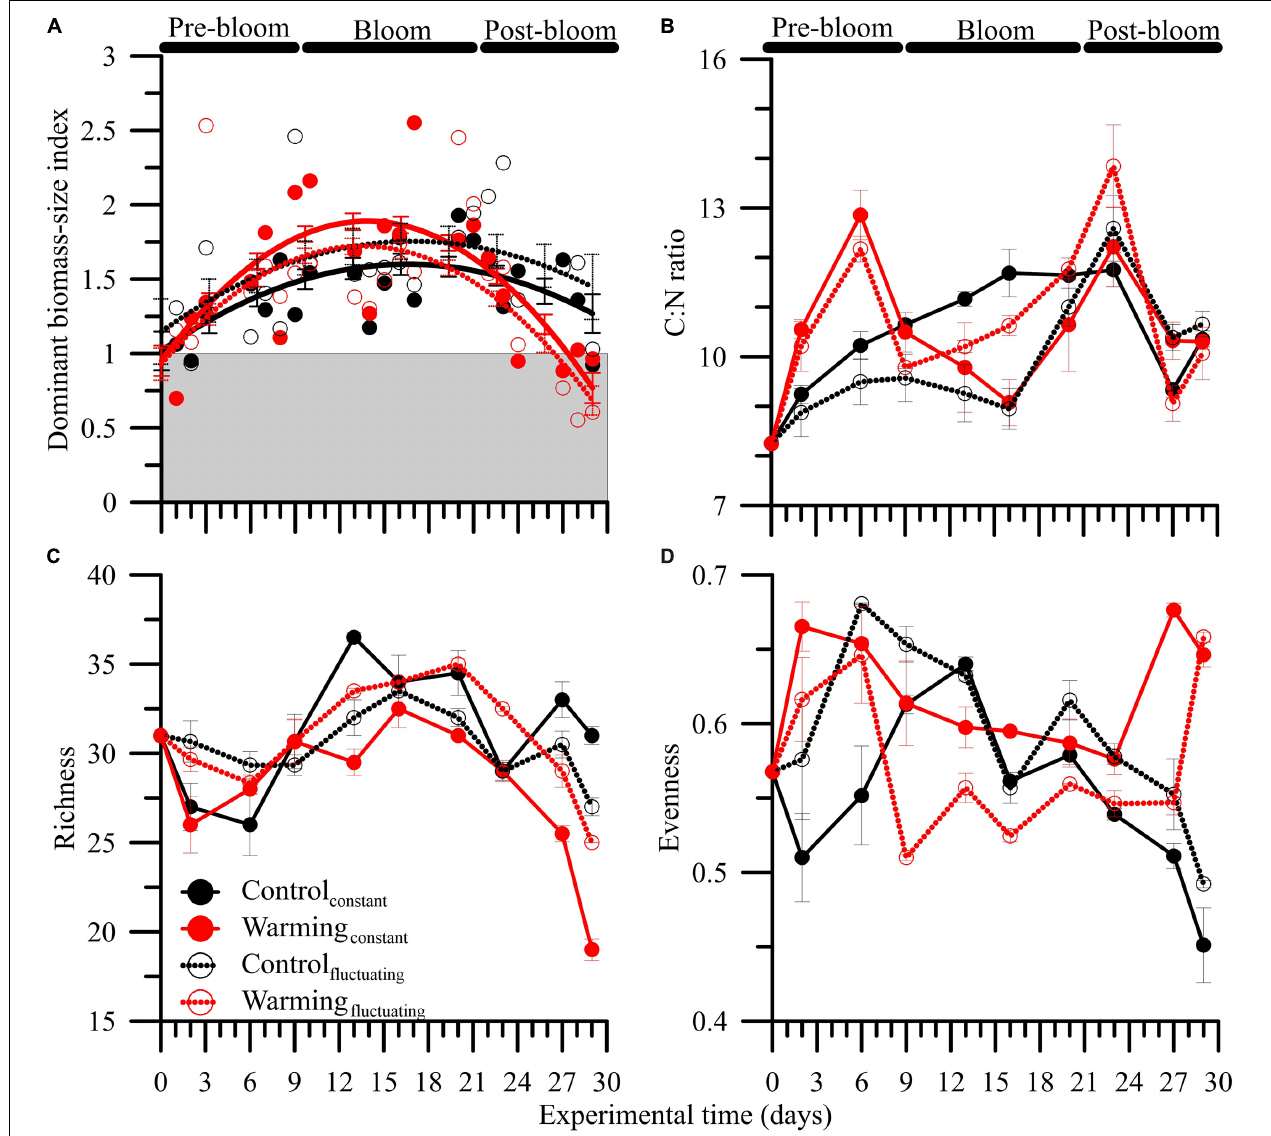
FIGURE 2 | Mean ( ± SD) (A) dominant biomass-size index based on fractionated chlorophyll a (Chl a > 5 µ m : Chl a < 5 µ m ), (B) carbon:nitrogen (C:N) ratios, (C) species richness (total n ◦ taxa), and (D) Pielou’s evenness in microbial plankton communities exposed to: two temperature treatments [Control (15 ◦ C) and Warming (18 ◦ C)] and regimes [Constant and Fluctuating ( ± 3 ◦ C respect to Present and Future)] over the experimental period. Solid lines in (A) represents non-linear regression fits, and vertical bars the 95% confidence